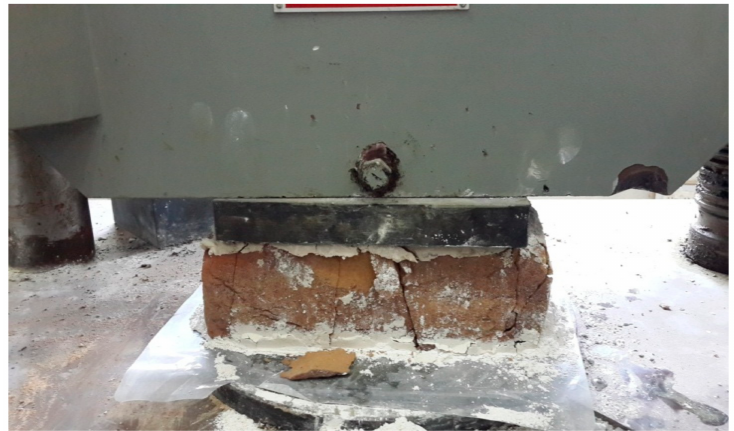
Figure 6. Compressive strength